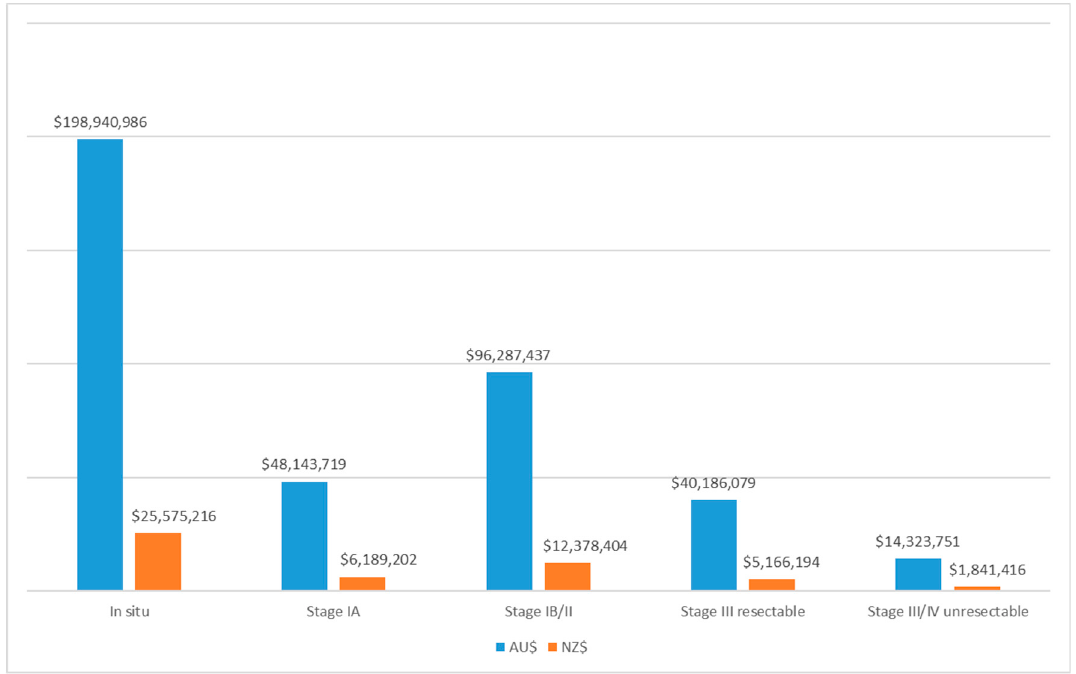
Figure 4. Total cost of first incident melanomas in 2021 by stage in Australia (AU$) and NZ (NZ$).